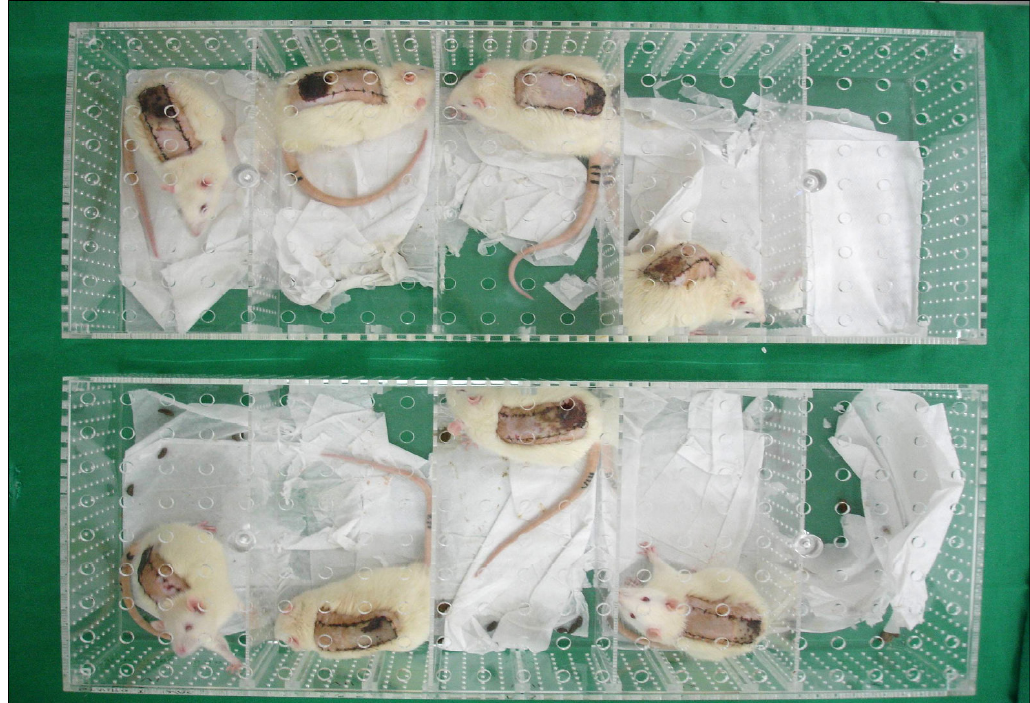
FIGURE 5 - Top view of the acrylic drawers with the rats in separate compartments, ready to be placed in the shelves in the interior of the